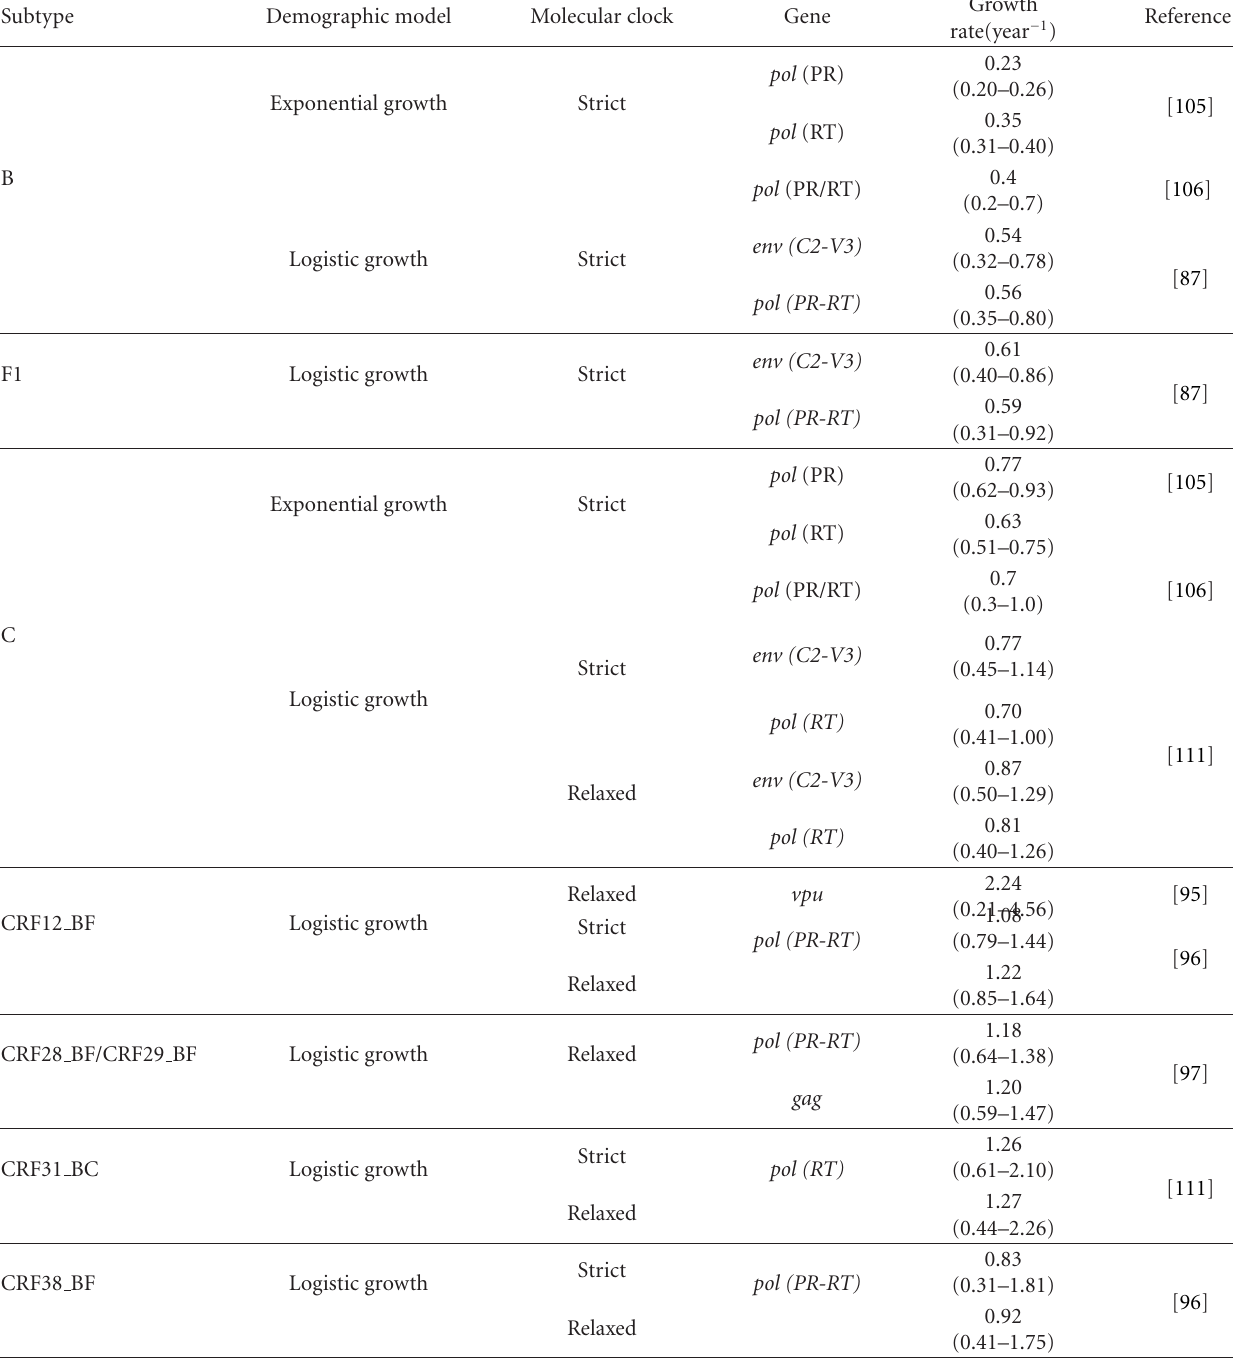
Table 1: Coalescent estimates of epidemic growth rate of HIV-1 clades in South